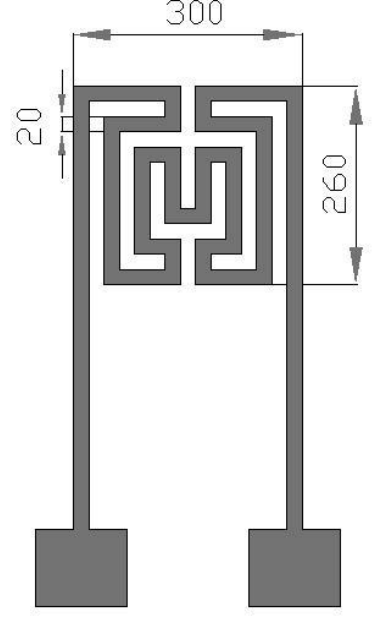
Figure 2. Micro temperature sensor